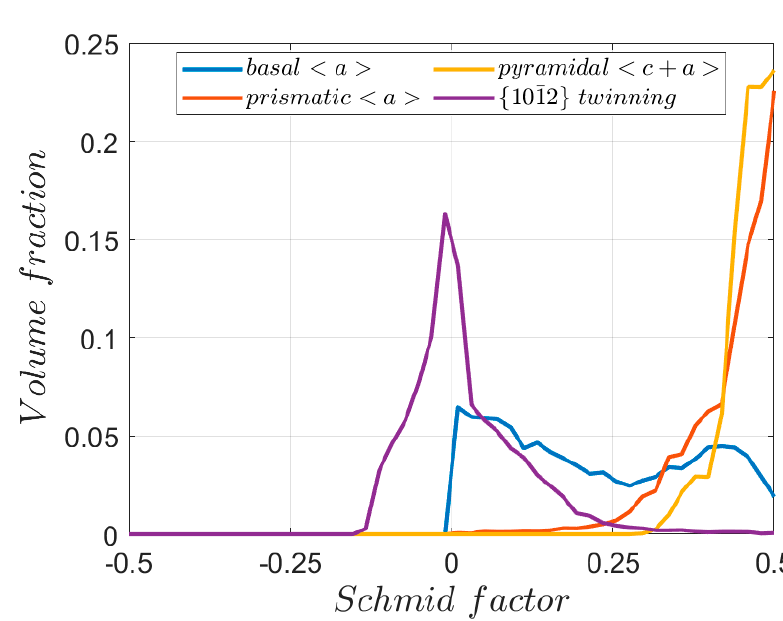
Figure 12. Schmid factor distribution calculated for major deformation mechanisms during the tensile loading along the ED of the 8P sample.